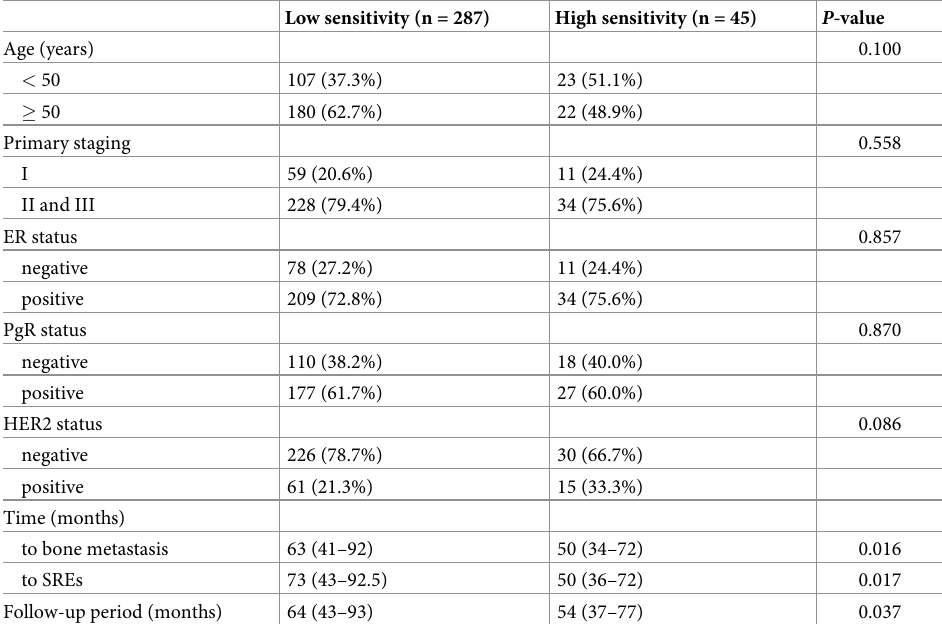
Table 1. Clinicopathological characteristics by sensitivity to alcohol.